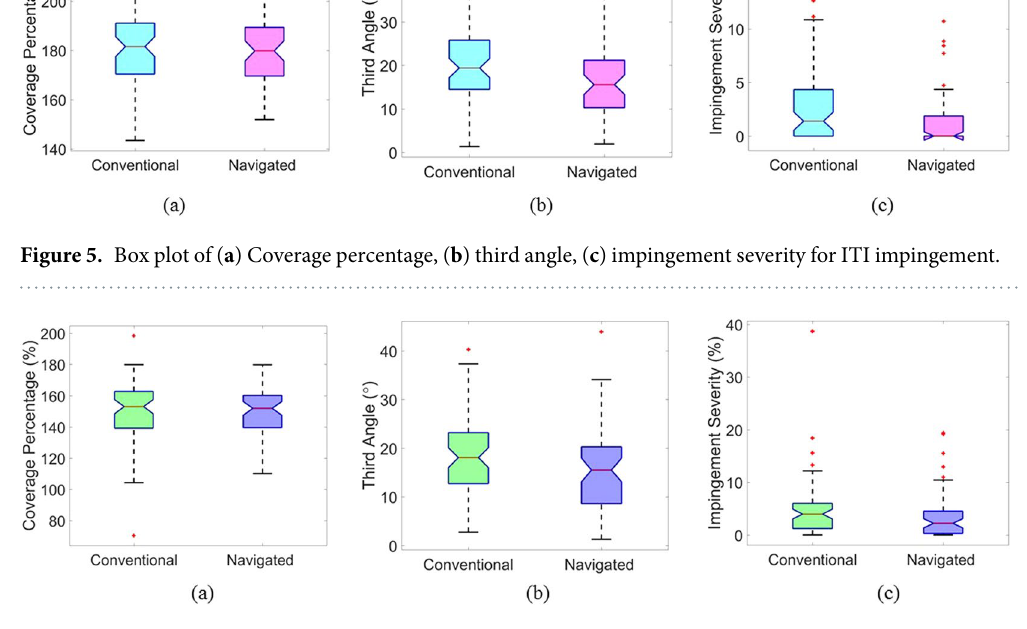
Figure 6. Box plot of ( a ) Coverage percentage, ( b ) third angle, ( c ) impingement severity for BTB